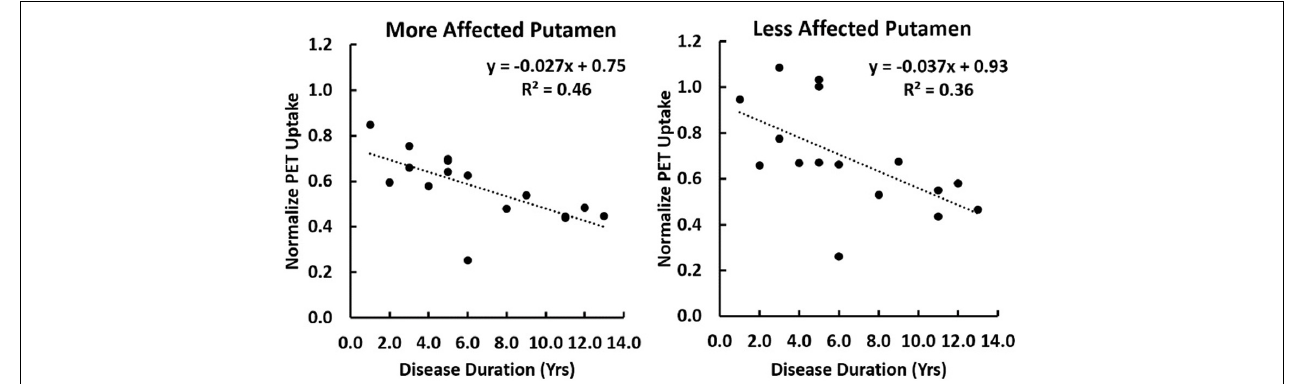
FIGURE 4 | A correlation of [C-11]-PE2I PET uptake normalized to the occipital lobe is shown with disease duration for the putamen lateralized into the more or less affected side. A multiple regression was performed with both subject age as disease duration as covariates. Significant correlation of PET uptake in the putamen with disease duration was found to be p = 0.004 and p = 0.022 on the more and less affected sides respectively. No significant correlation with subject age was